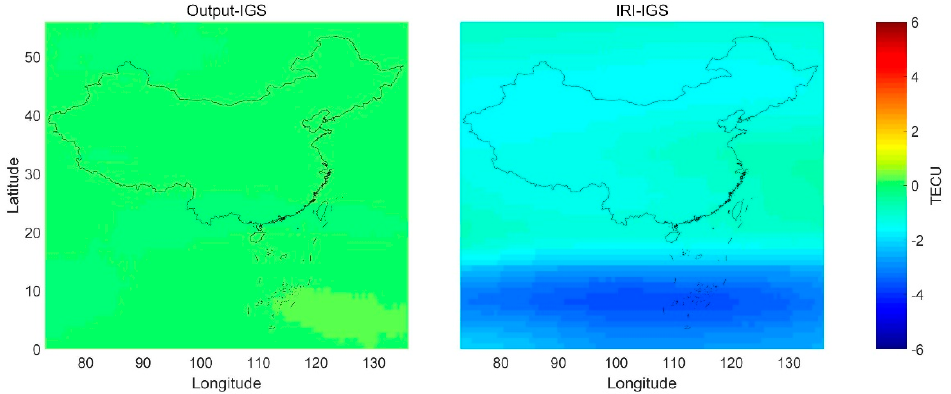
Figure 3. The average difference between the output maps of our model and target IGS TEC maps (+2 h) and between IRI TEC maps (+2 h) and target IGS TEC maps for the test data.